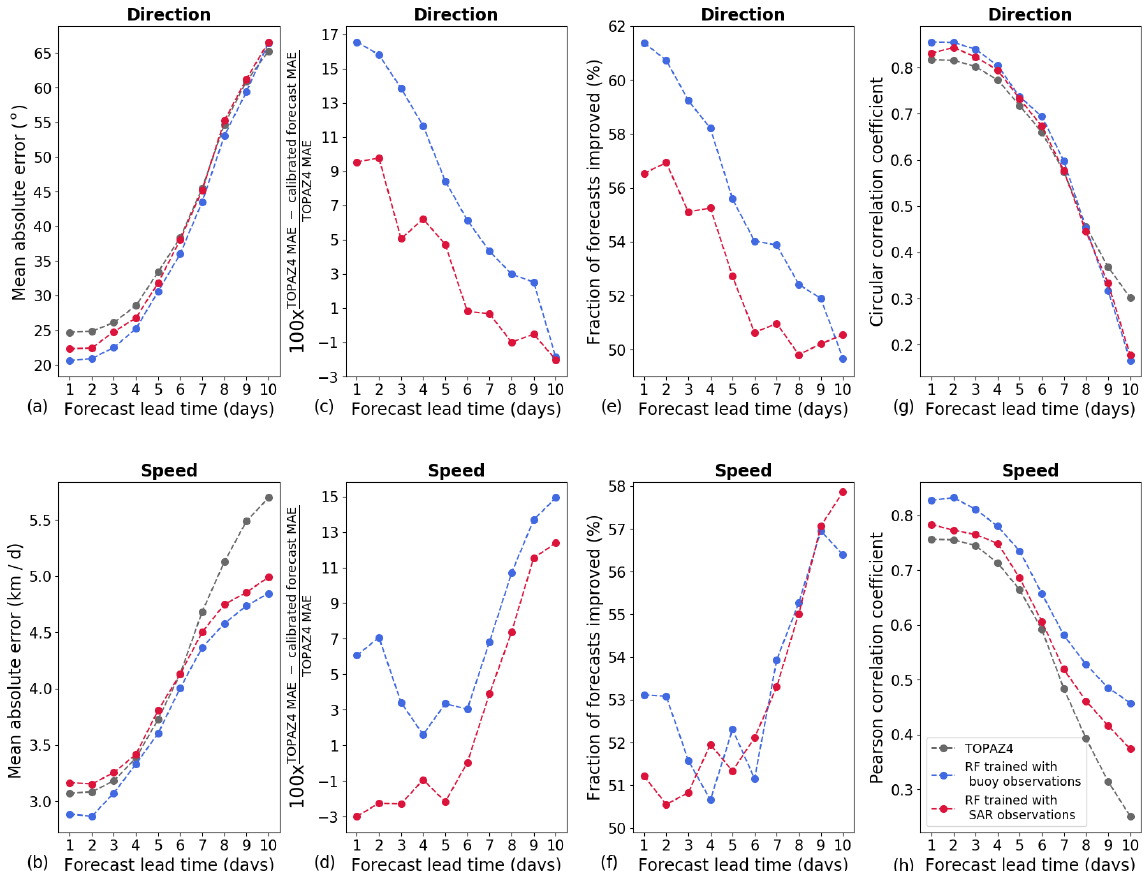
Figure 3. Evaluation of the performances of the calibrated forecasts produced using random forest (RF) algorithms and the TOPAZ4 fore- casts during the period from June 2020 to May 2021. IABP buoy observations have been used as reference. Mean absolute errors (MAE) of the forecasts for the direction (a) and the speed (b) . Relative improvement tion (c) and the speed (d) . Fraction of calibrated forecasts with lower absolute errors than the TOPAZ4 forecasts for the direction (e) and the speed (f) . Circular and Pearson correlation coefficients between the forecasts and the buoy observations for the direction (g) and the speed (h) ,